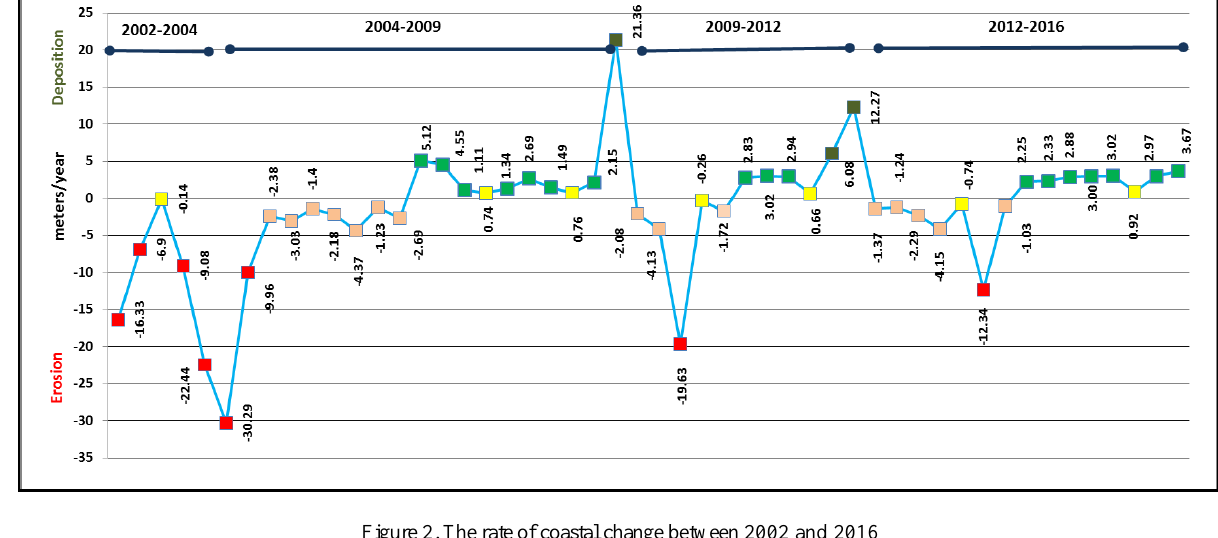
Figure 2. The rate of coastal change between 2002 and 2016